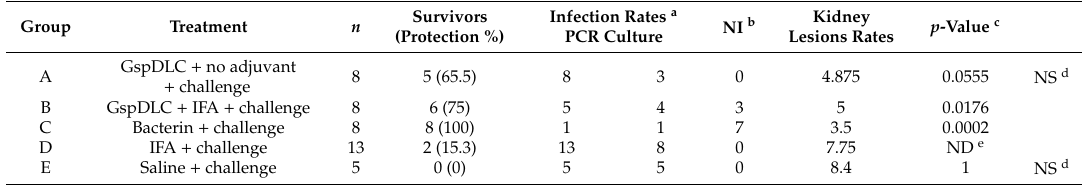
Table 1. Treatment protocols applied to hamster groups, protection percentage, infection, and kidney lesion